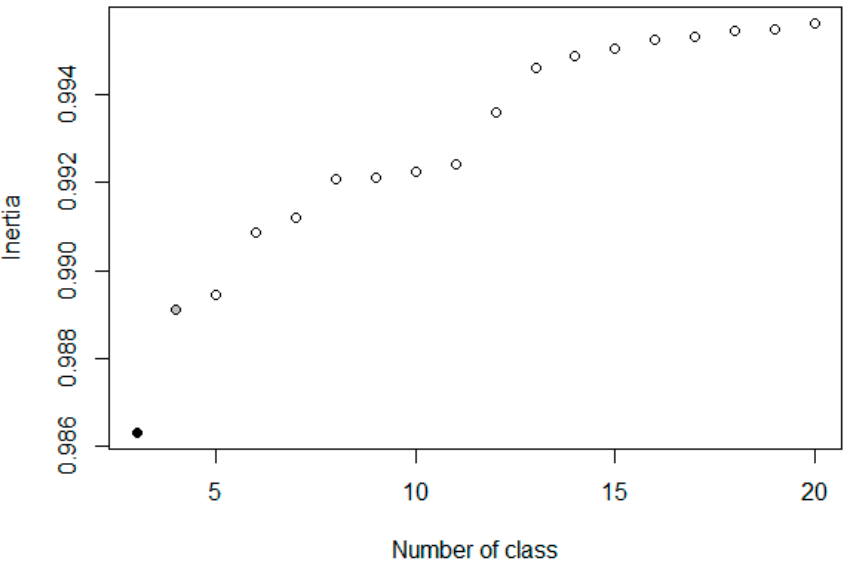
Figure A2. Relative inertia loss as a function of number of clusters. The best score according to this criterion is represented by a black dot and the second by a gray dot.